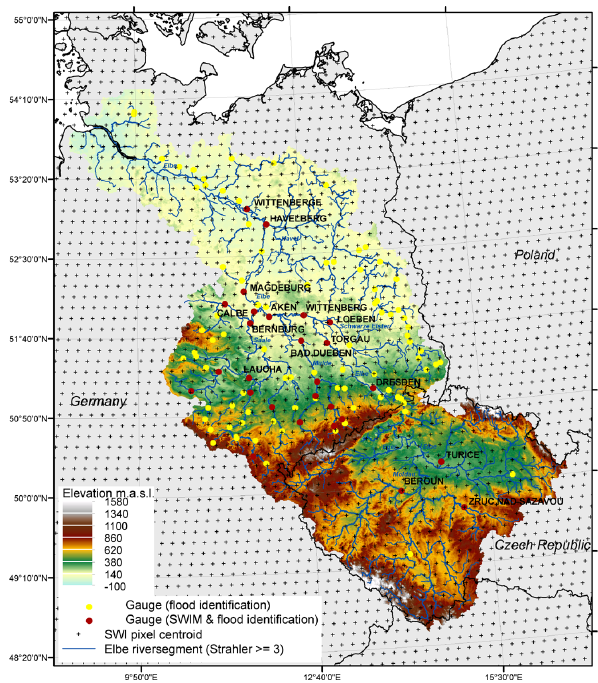
Fig. 1. Topographic map of the Elbe River basin. Yellow dots: dis- charge gauges applied in flood identification. Red dots: discharge gauges applied in flood identification as well as hydrologic model calibration and validation. Crosses: location of pixel centroids of the scatterometer